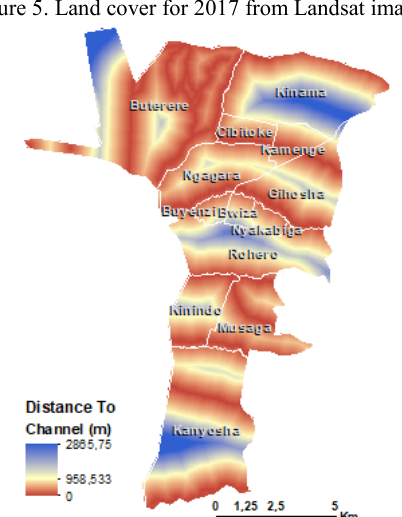
Figure 9. Distance to nearest hospitals